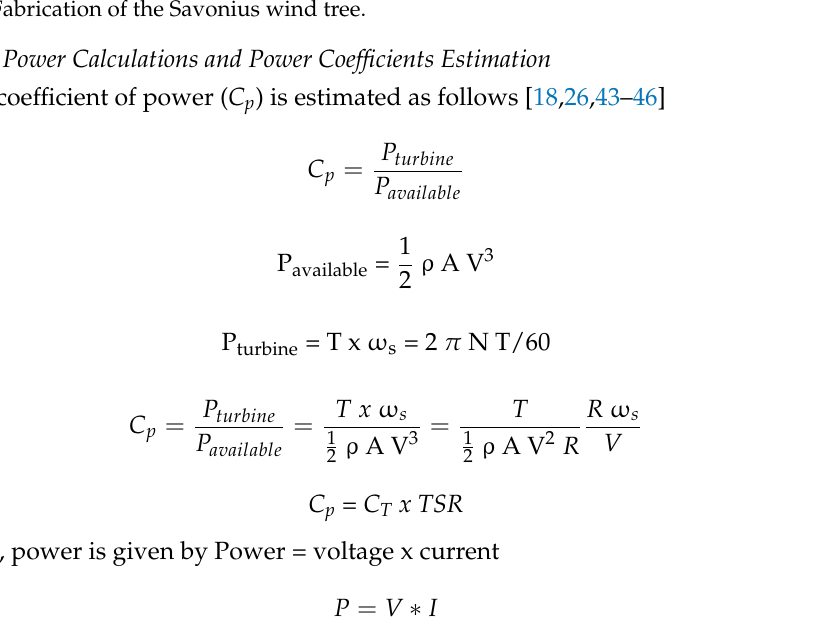
Figure 7. Fabrication of the Savonius wind